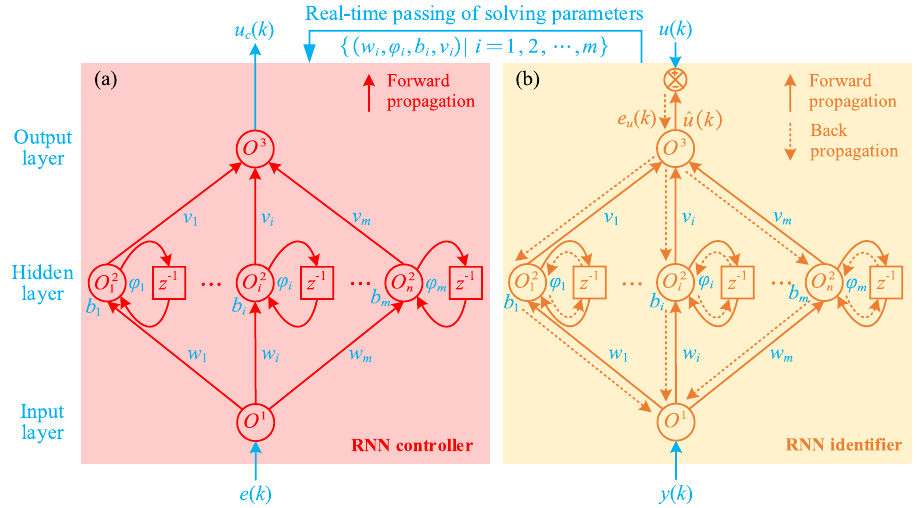
Figure 3. Network structures of ( a ) the RNN controller and ( b ) the RNN